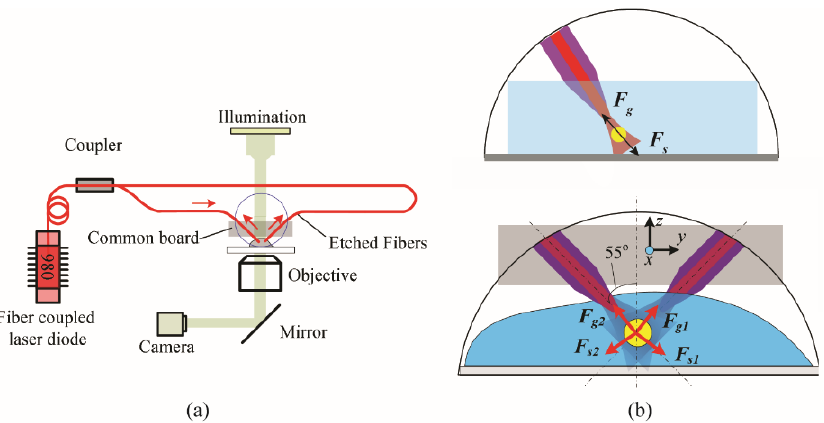
Figure 2. ( a ) Experimental setup and ( b ) working principle of the single (top) and inclined dual etched fiber − based optical trapping system (bottom). F s = scattering force; F g = gradient force. The inclined angle is defined as the angle between a fiber and the vertical direction. The gravity and buoyancy forces are not drawn.